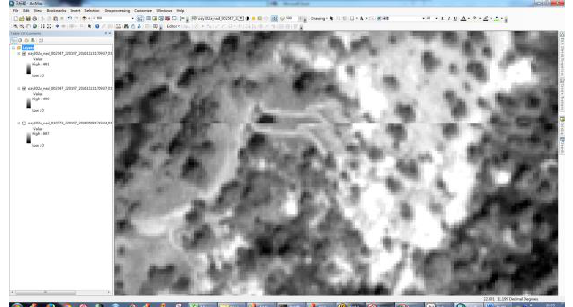
Figure 9. The accuracy of plane edge connection exceeds the